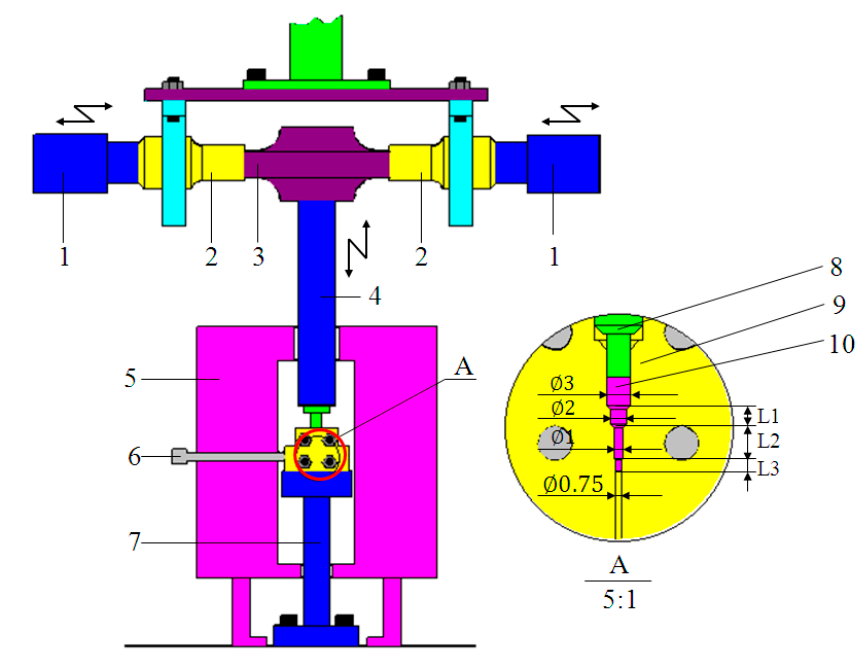
Figure 1. A schematic of the ultrasonic microextrusion system.